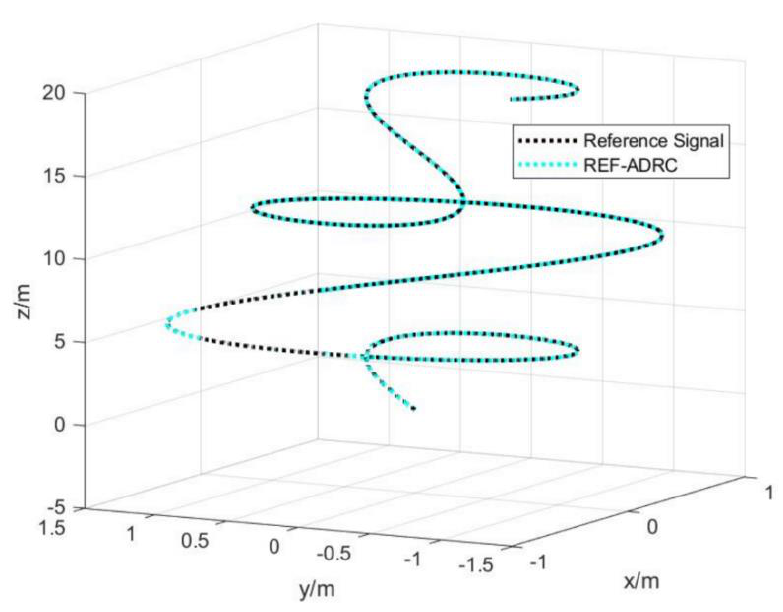
Figure 5. Track trace curve.